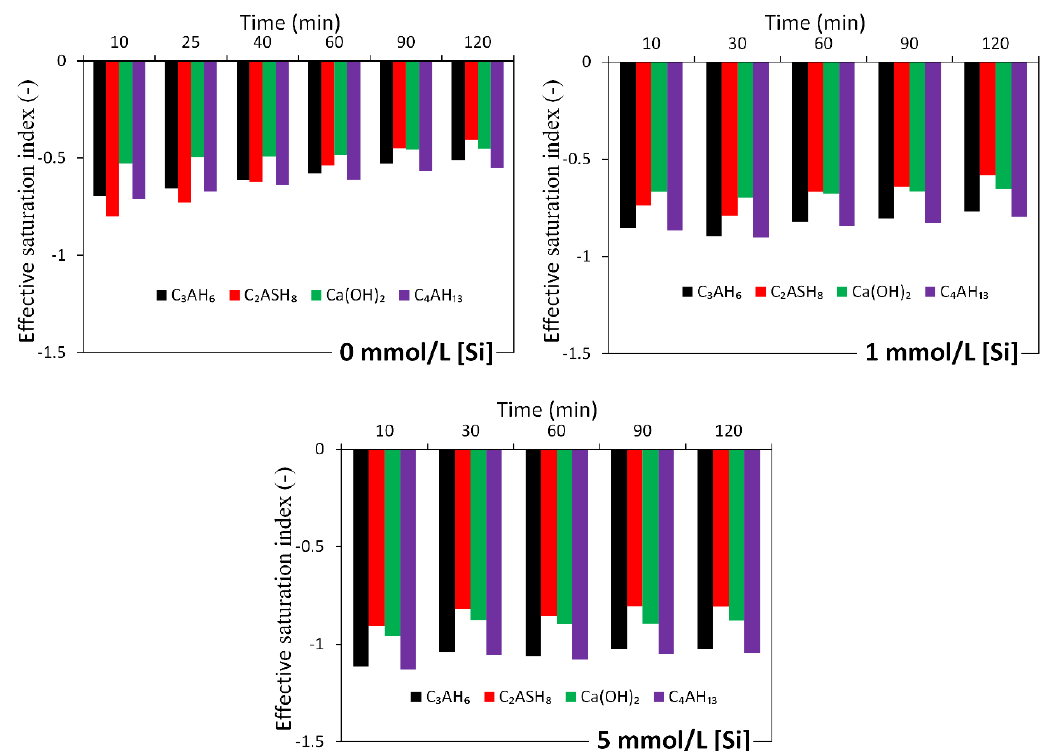
Figure 6. Calculated effective saturation indexes (ESI) for secondary reaction products for the dissolution of slag in 0.1 mol/L sodium hydroxide solution with and without soluble Si.